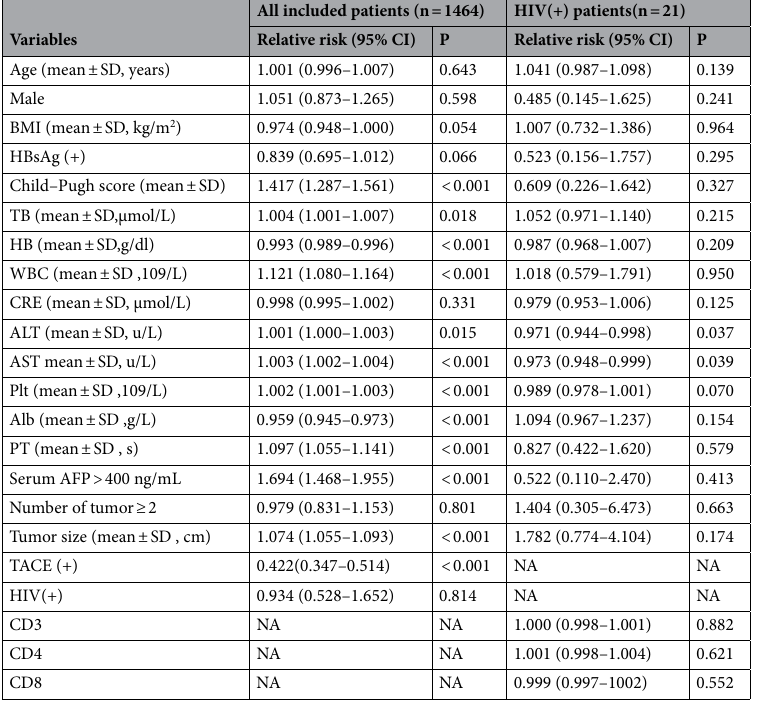
Table 1. The variables in the univariate analysis for the BCLC-B stage. BMI body mass index, HBsAg Hepatitis B surface antigen, TB total bilirubin, AFP alpha-fetoprotein, PT prothrombin time, WBC white blood cell, Cre creatinine, HB hemoglobin, Plt platelet, Alb